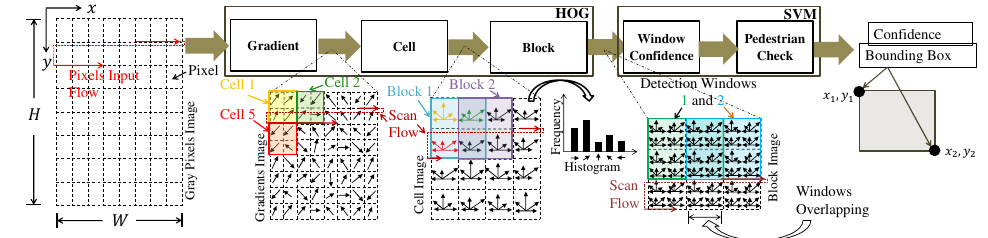
Figure 2. HOG and SVM overview. The SVM scans the block image using detection windows and determines whether or not each window contains a pedestrian. Colors help to differentiate cells, blocks, and detection